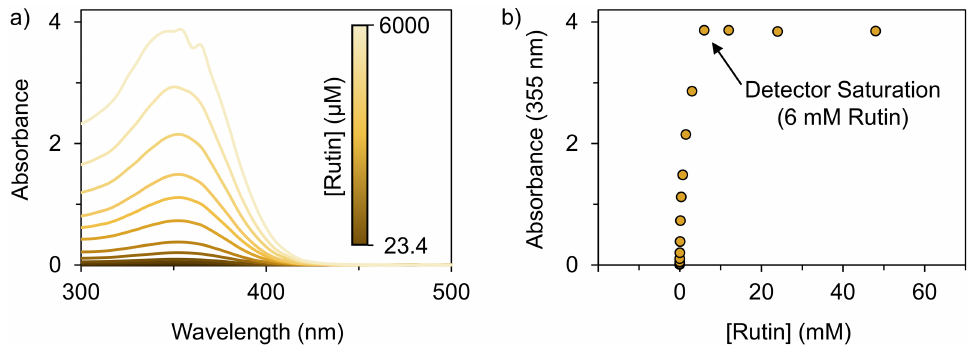
Figure 3 Optimizing the rutin concentration for aluminum quantification. The absorbance spectra of rutin in DMSO as a function of concentration. (A) Absorbance spectra of rutin ranging in concentration from 23.4–6,000 µ M. (B) The absorbance of rutin at 355 nm as a function of rutin concentration (23.4 µ M–48.0 mM), which shows the rutin concentration (23.4–375 µ M) where the absorbance at 355 nm falls within the 0.1–1.0 range and the rutin concentration (6 mM) that results in the saturation of the de- tector ( i.e., the maximum absorbance that can be detected). Note that the values in panel (B) are the av- erage of n = 3 measurements whereas the error bars, which are small and within the boundaries of the marker, are the standard deviation of n = 3 measurements. Full-size DOI: